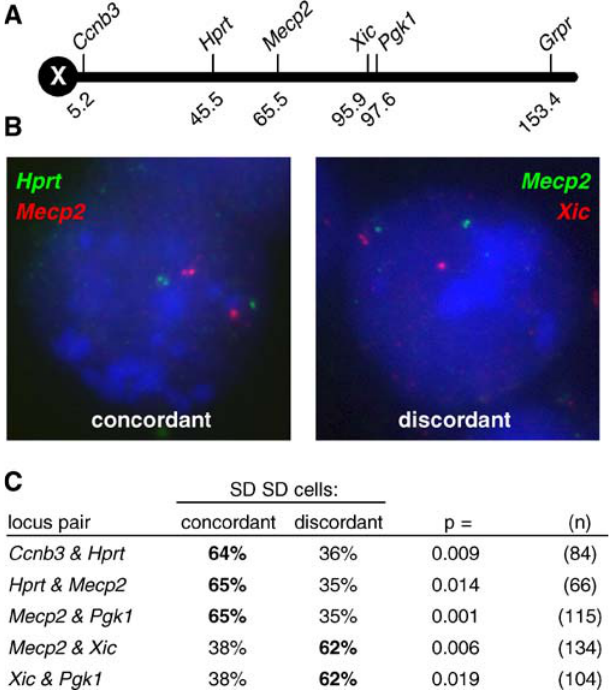
Figure 2. X Chromosomes Differ from One Another in ES Cells (A) Map of the X chromosome showing positions (Mb) of loci assayed for SIAR. (B) Concordant Mecp2 (red) and Hprt (green) (left) and discordant Xic (red) and Mecp2 (green) (right) FISH signals. (C) Frequencies of concordance and discordance for specified locus pairs in ES cells. p -Values, determined using a v 2 test, reflect the probability that the observed distributions are random. DOI: 10.1371/journal.pbio.0040159.g002